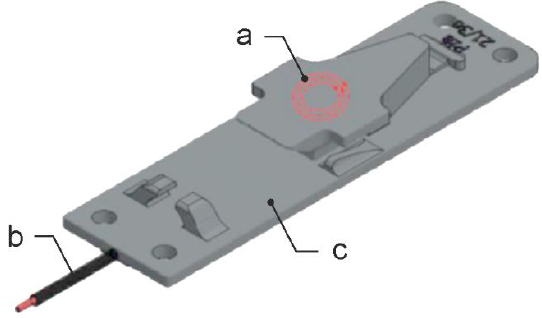
Figure 15. Snow melting device as an inductor for induction turnout heating, placed in a turnout slide plate; ( a ) inductor, ( b ) slide plate, and ( c ) high frequency power supply wire [23,24].